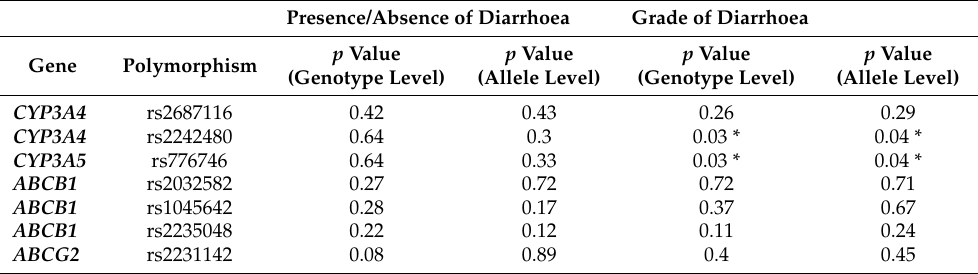
Table 4. p value by chi-squared test at genotype and allele level for the presence/absence and the grade of diarrhea. Correlation between diarrhea side effect and polymorphisms linked to MKI